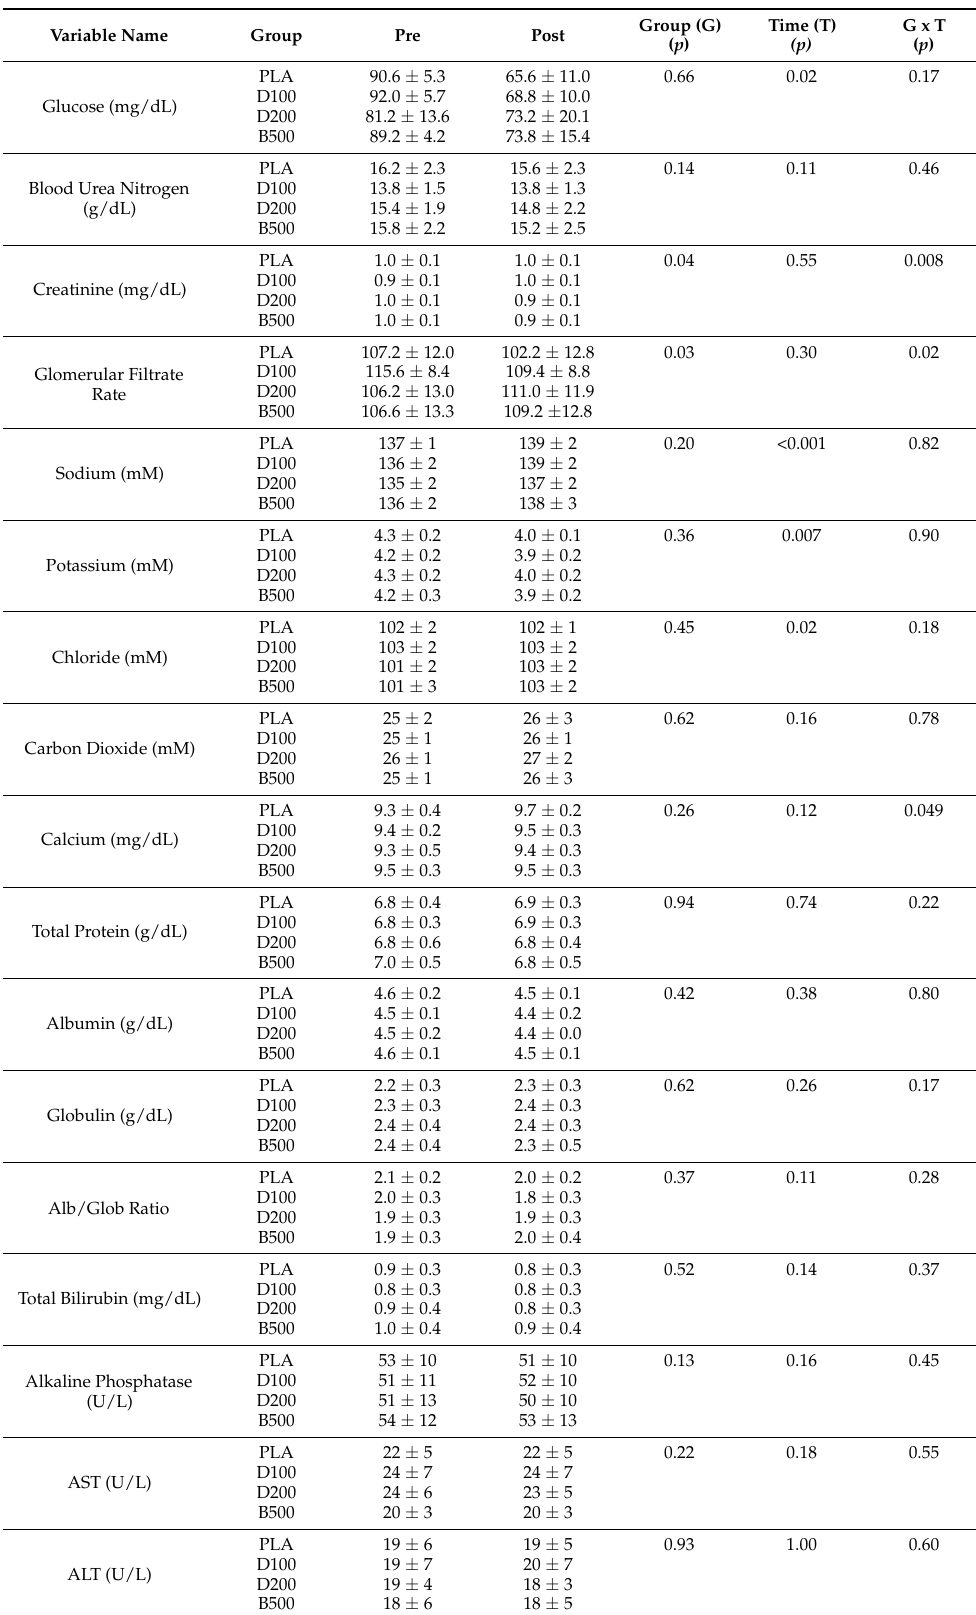
Table 7. Comprehensive metabolic